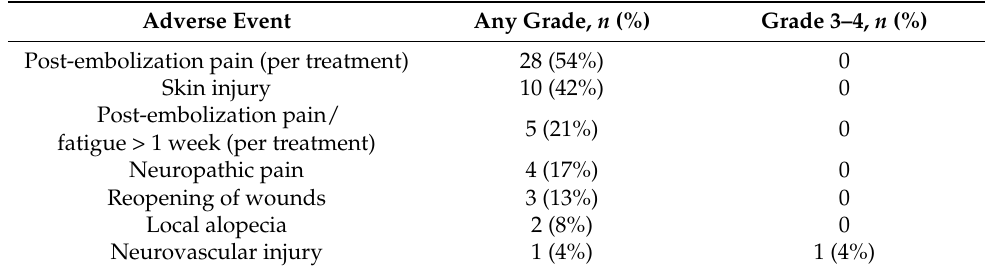
Table 3. Safety summary (out of 52 DEE